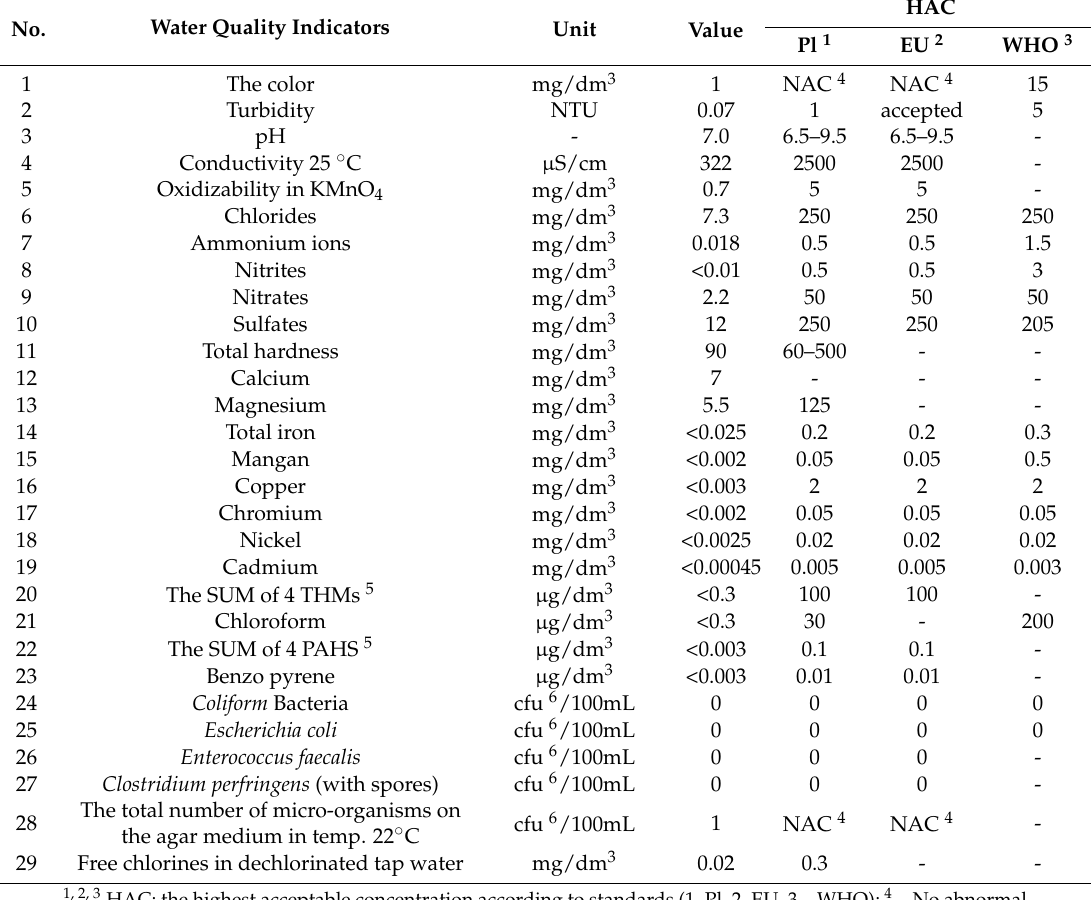
Table A1. Chemical parameters of water used for experiment media